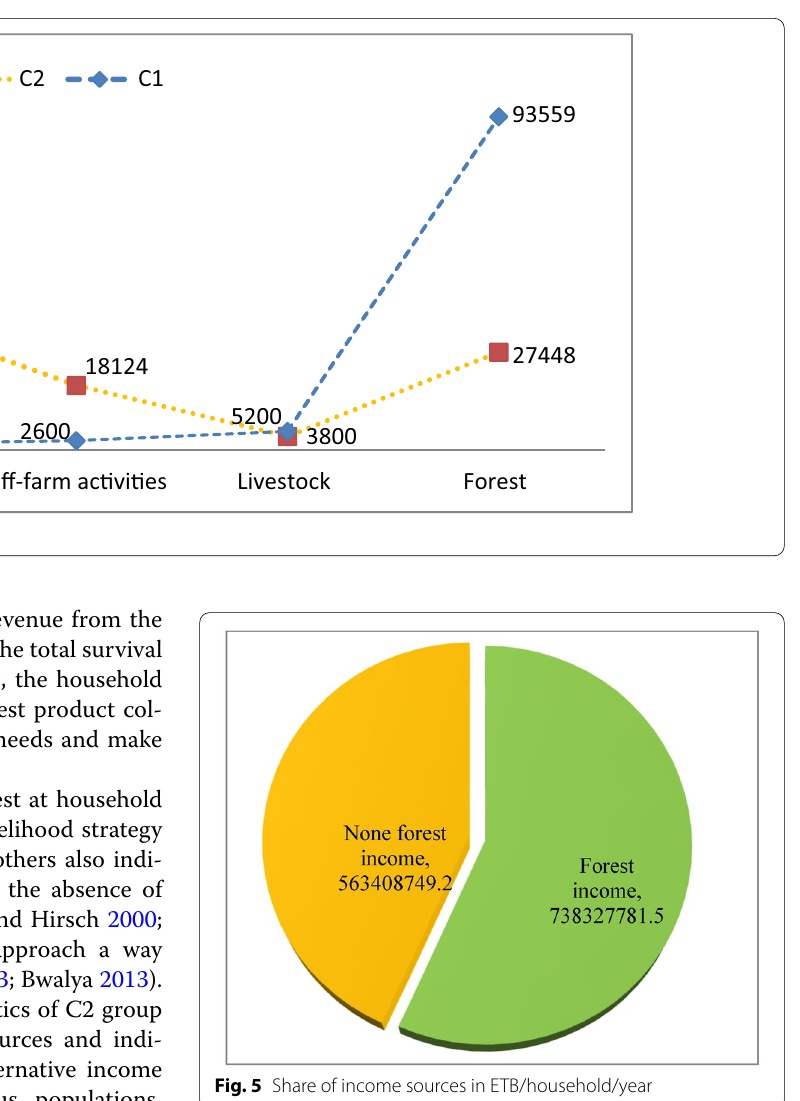
Fig. 5 Share of income sources in